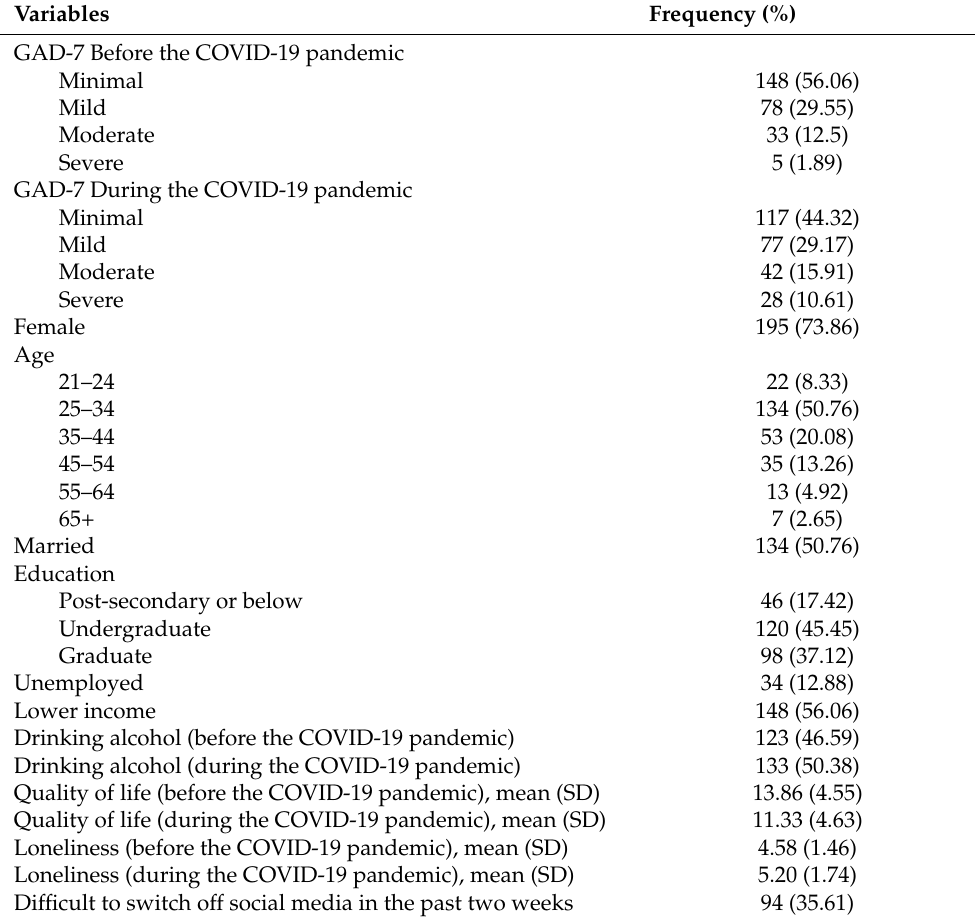
Table 1. Descriptive characteristics of the study participants (n =